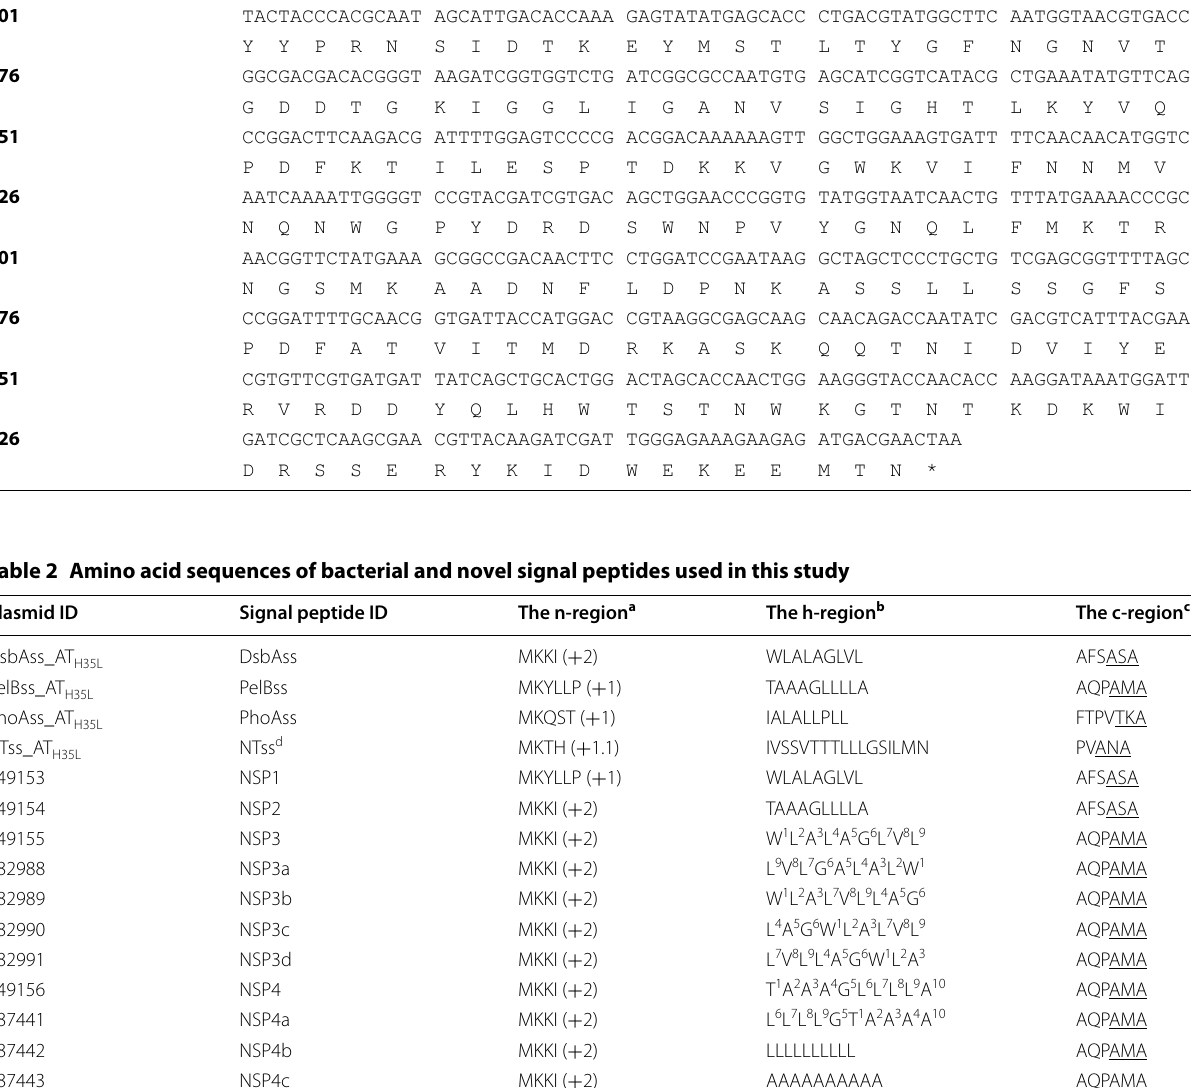
ss stands for signal sequence a Numbers in parentheses indicate the positive net charge in the n-region b Numbers indicate the position of amino acids in the h-region c The cleavage sites are underlined in the c-region